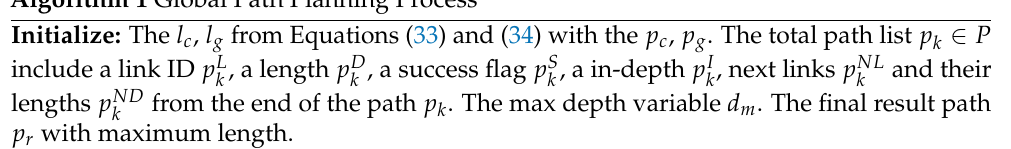
Algorithm 1 Global Path Planning Process